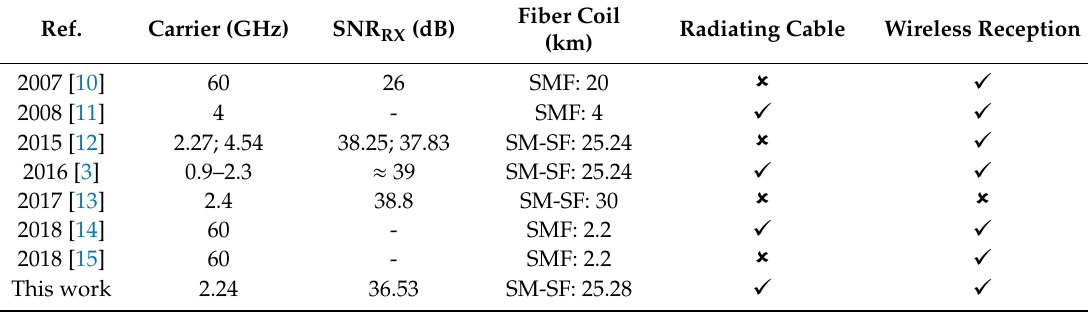
Table 1. Relevant works that consider wireless optical communications (WOC). Ref.